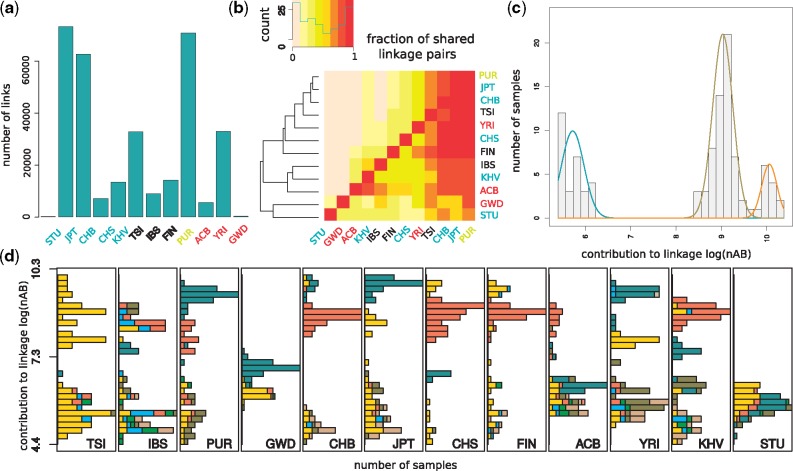
—Characteristics of interchromosomal linkage among common variants in the coding regions (>5% minor allele frequency). (a) Number of interchromosomal linked variants with a false discovery rate (FDR) < 5% in the 1000 Genomes populations, when analyzed independently. The FDR was calculated by comparing the P value of each linked pair to the distribution of P values after permuting chromosomes across individuals. Populations labels are colored according to the continent: blue for Asia, red for Africa, black for Europe and yellow for others. (b) Fraction of interchromosomal linked variants in one population (row) that are also linked in another population (column). Darker colors indicate a higher proportion of linked variants. The order of the populations is determined by the hierarchical clustering graph shown on the left, calculated on the basis of the sharing of linked variants. (c) Contribution of Chinese from Bejing individuals to the linkage signal (bars) given by the number of linked minor alleles (nAB). Individuals with similar nAB values were grouped by a Gaussian mixture model, whose fitted distributions are shown as colored lines. (d) Distribution of nAB for individuals from different 1000 Genomes populations. Colors indicate the sequencing center per individual. Individuals sequenced in multiple centers were marked with a separate colors.